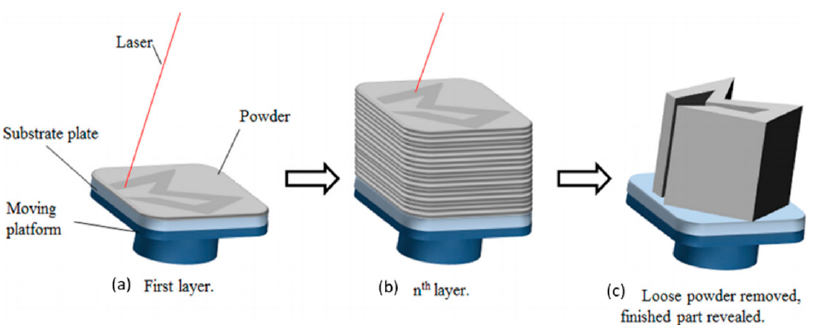
Figure 18. Recent SLM stage illustration comprised of three main steps: ( a ) Melting selective areas of the powder bed with a high-power laser; ( b ) repeating the process for successive layers; ( c ) cleaning the loose powder for the finishing stage. (Adapted with permission from reference [53].)